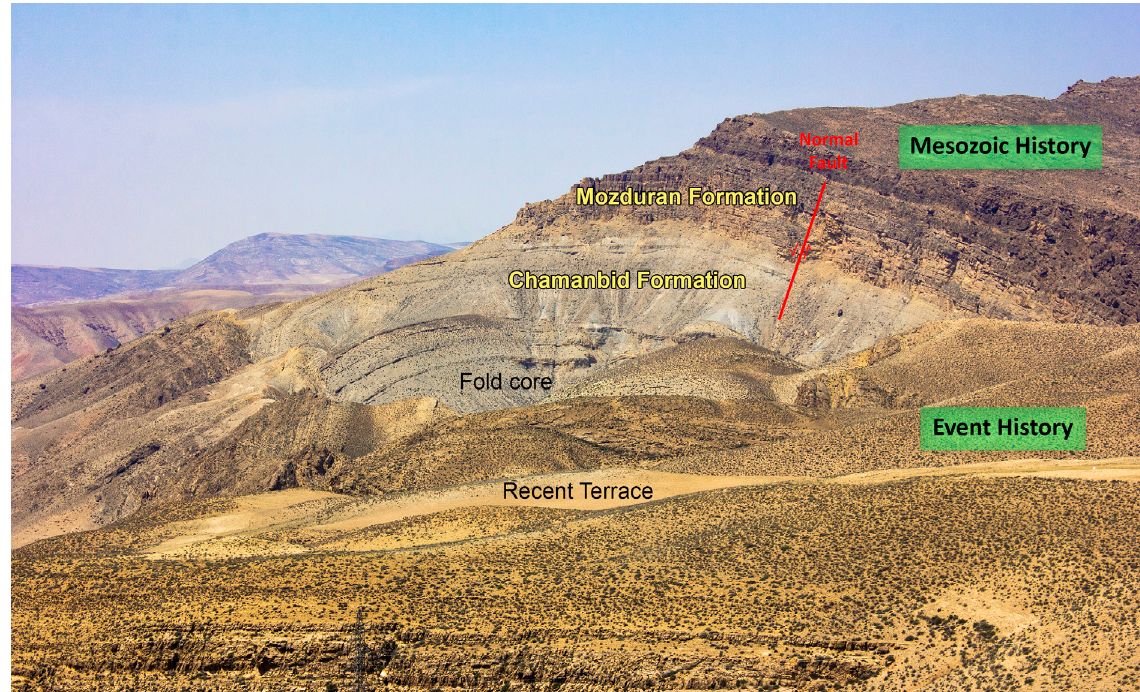
Figure 11. Geodiversity and dynamic equilibrium in an overturned and eroded anticline in the Mashhad-Kalat Road (Photo